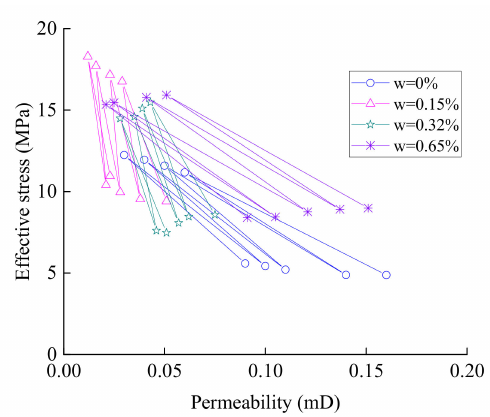
Figure 8. Permeability-e ff ective stress curves of samples with di ff erent moisture